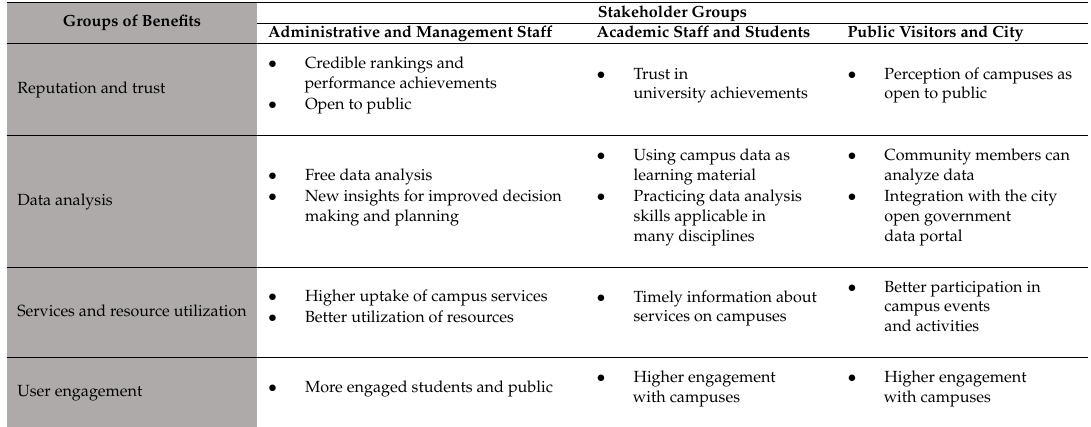
Table 1. Benefits of open data on campus for different stakeholder